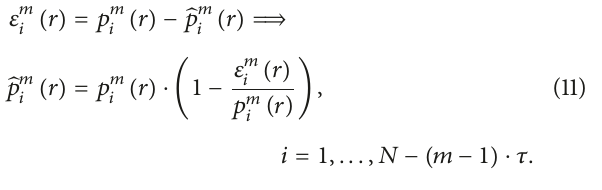
Figure 2: Illustrative example of inconsistent results: a threshold- length ( 𝑟 - 𝑁 ) plane for XApEn estimated from SBP and PI signals of rats at baseline (black lines and circles) and stress (red lines and circles). Gray regions: estimated XApEn is higher at baseline than at stress. White regions: XApEn is higher at stress than at baseline . Circles: threshold 𝑟 max for which XApEn reaches its maximal value; foraparticular 𝑁 ,theemptycircledenotestheloweroftwomaximal XApEn values. Embedded plot shows a complete threshold profile for 𝑁 = 4000 . Results are obtained from borderline hypertensive rats exposed to shaker